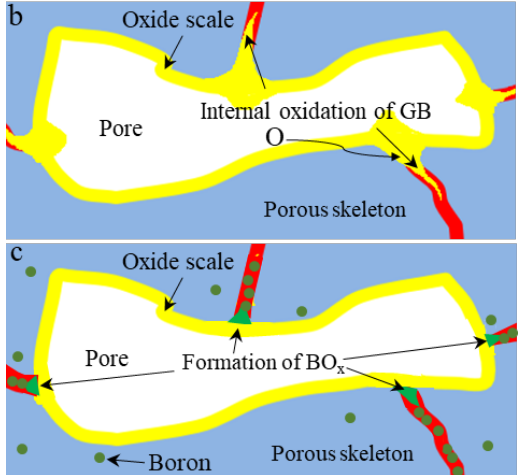
Figure 10. Schematic diagram for intergranular oxidation and the role of boron. ( a ) Porous material with highly exposed grain boundaries; ( b ) intergranular oxidation of porous materials; ( c ) formation of boron oxides inhibits inward diffusion of oxygen.